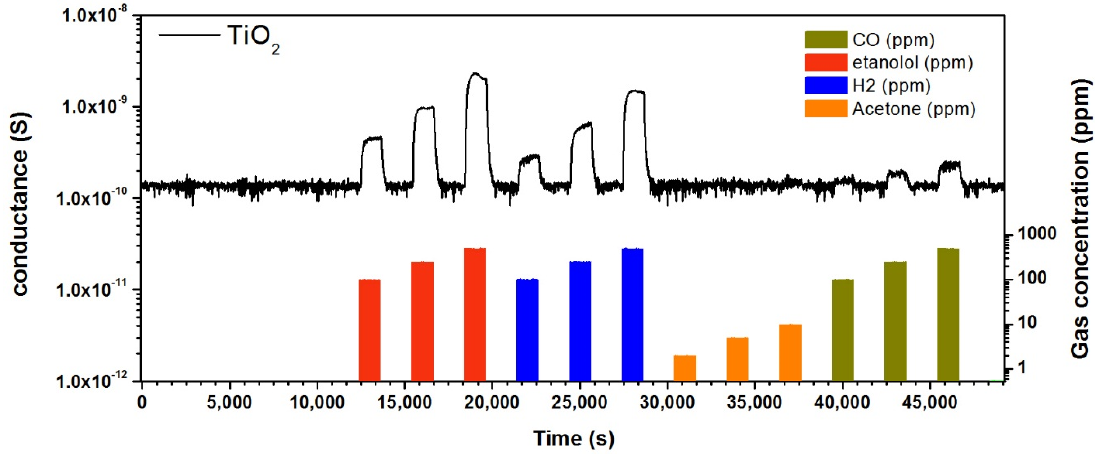
Figure 8. Dynamic response of TiO 2 NWs toward ethanol (100, 250, 500 ppm), H 2 (100, 250, 500 ppm), acetone (2, 5, 10 ppm), and CO (100, 250, 500 ppm) at 400 °C. RH = 40%, with an applied voltage equal to 1 V.